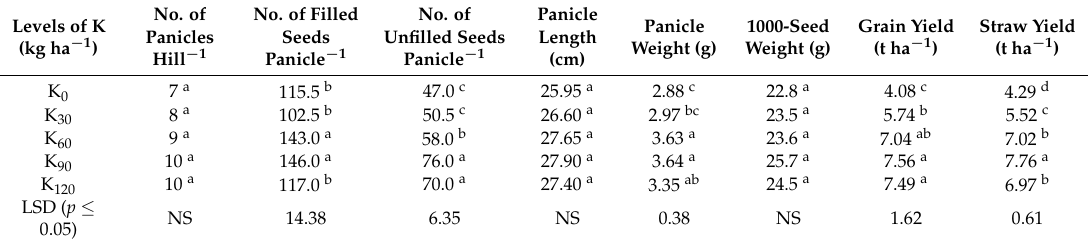
Table 2. Yield components and yield of hybrid rice (var. Arize 6444) as influenced by potassium fertilization (means for 2016 and